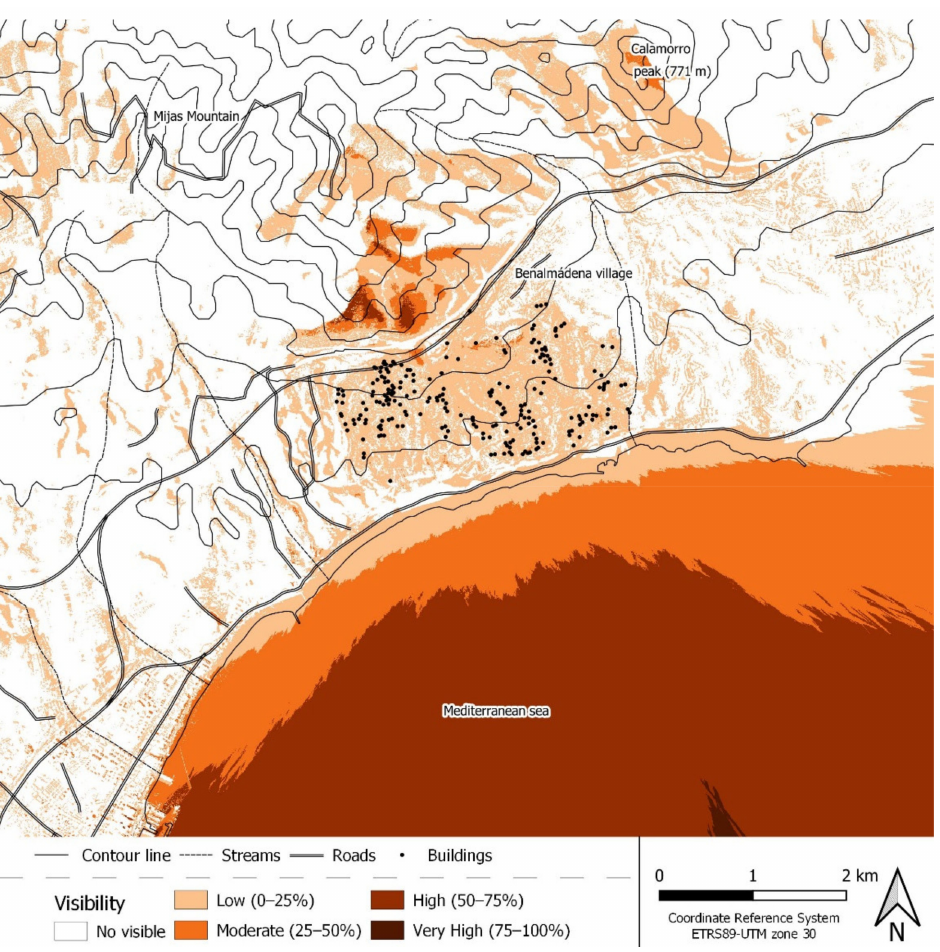
Figure 7. Concentration of views according to the percentage of dwellings from which it is perceived (own elaboration).